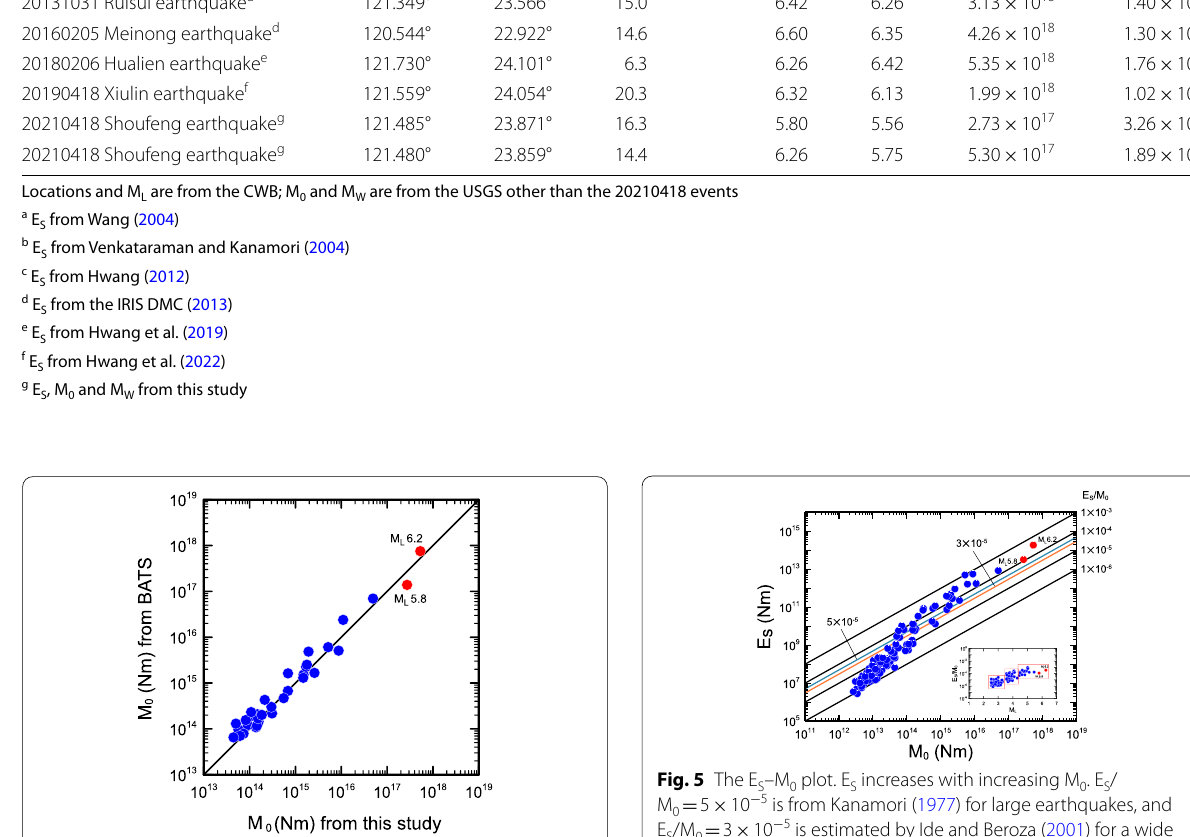
Fig. 4 Comparison of M 0 from the BATS and M 0 from this study for M L > 3.5. M 0 derived from the method of Andrews (1986) coincides with that determined from the BATS using moment tensors inversion